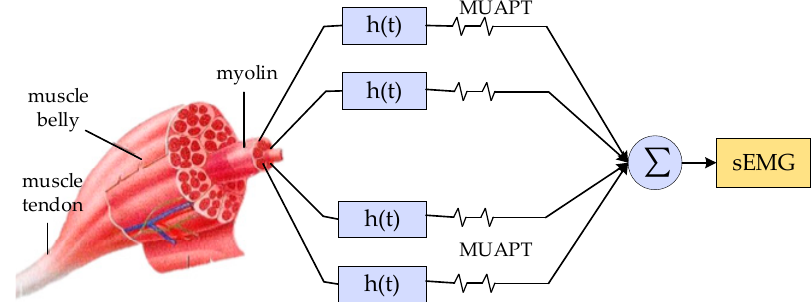
Figure 6. Schematic diagram of the generation principle of sEMG. On the left is the skeletal muscle composed of muscle tendons and belly. The basic unit in the belly is the muscle myolin [12]. Each muscle myolin is an independent unit of kinetic energy and structure. The action potential h ( t ) produced by tens of thousands of contraction changes of muscle myolins is transmitted to the skin surface and superimposed in time and space to form sEMG.